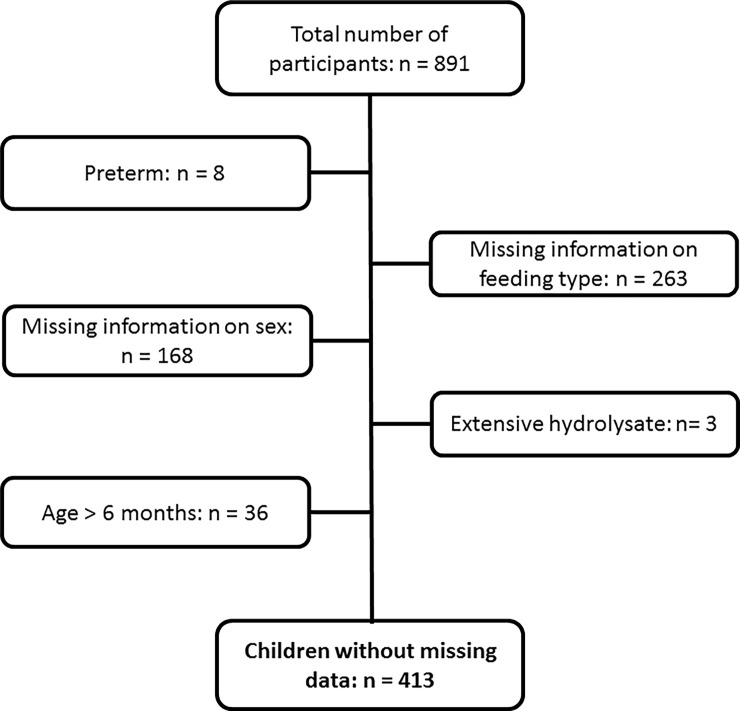
Participant flow chart.